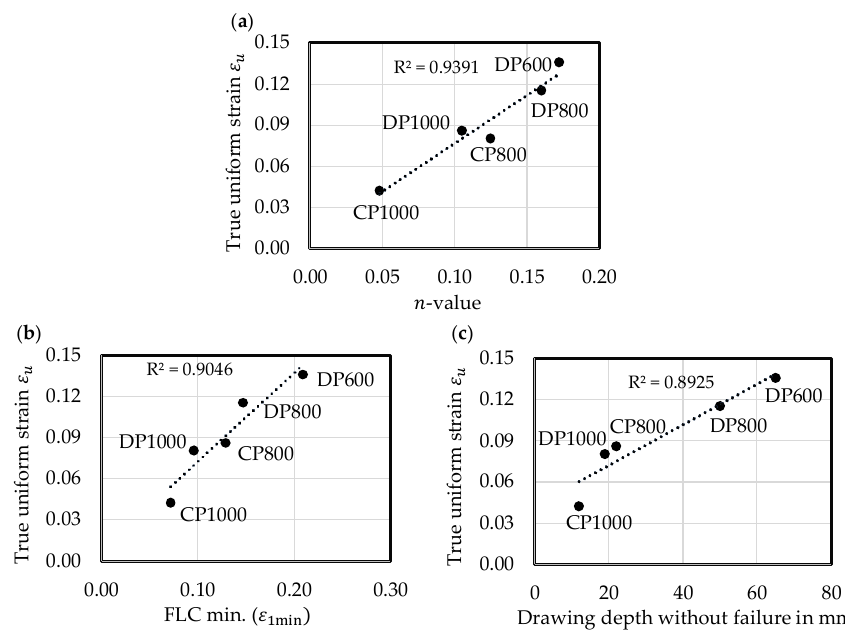
Figure 9. True uniform strain ε u as measure for global formability: ( a ) Correlation with n-value; ( b ) Correlation with forming limit curve (FLC) min.; ( c ) Correlation with drawing depth without failure of cross-die samples.